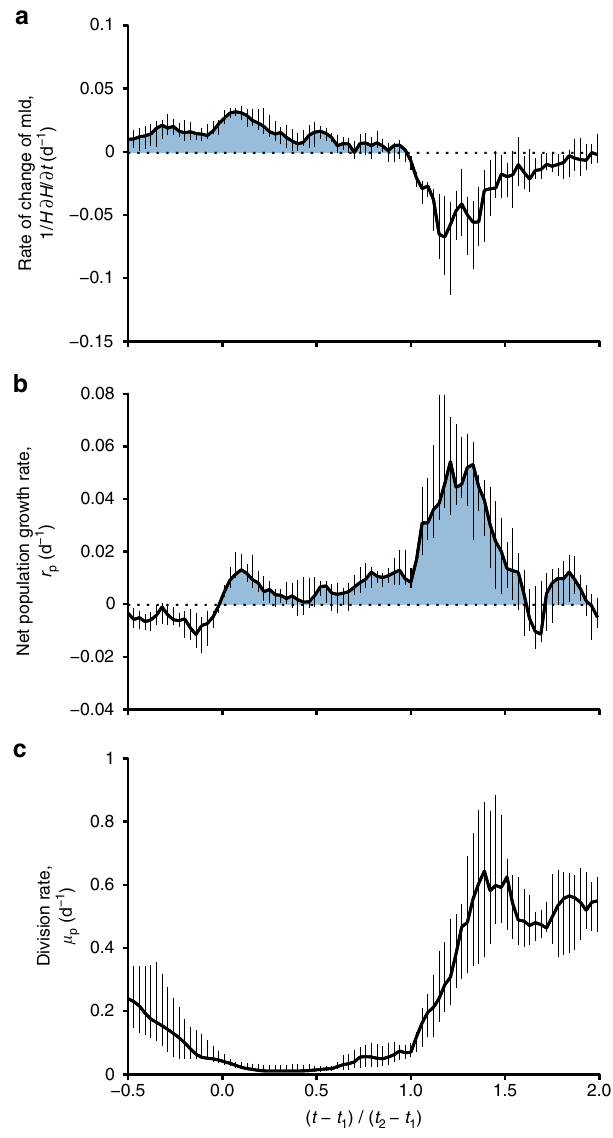
Fig. 3 Rate of change of physical and biological variables. Median (solid thick line) and interquartile range (vertical bars) of the rate of change of mixed layer depth ( a , 1 H ∂ H ∂ t ), the net phytoplankton population growth rate ( b , r p ), and phytoplankton division rates ( c , μ p ), estimated from the 12 time series collected by the fl oats. The time axis is rescaled by the onset times of the weak winter accumulation phase ( t 1 ) and the spring bloom ( t 2 ) introducing τ ¼ t (cid:2) t 1 ð Þ = t 2 (cid:2) t 1 ð Þ . τ = 0 corresponds to the initiation of the weak winter accumulation phase and τ = 1 corresponds to the initiation of the spring bloom. The time span between τ = 0 and τ = 1 corresponds to the duration of the weak winter accumulation phase and it is ~120 days